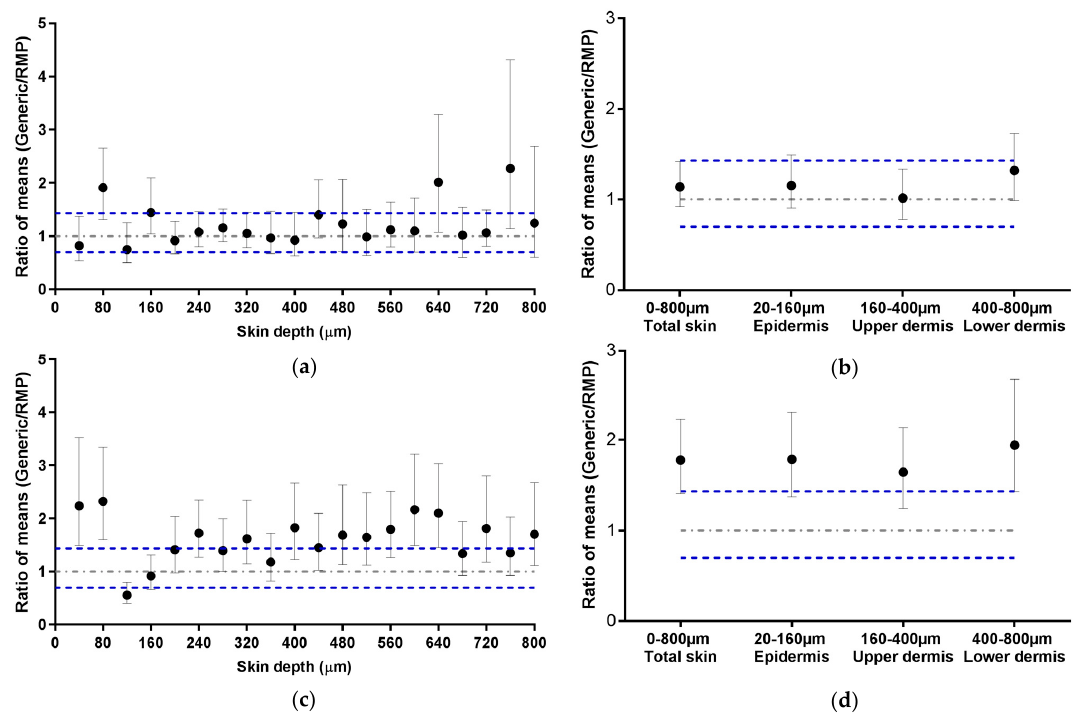
Figure 5. Ratio of mean ECZ depositions from the ECZ 1% Generic cream 1 and the RMP ( ): ( a ) in porcine skin lamellae (2 × 20 µm + 19 × 40 µm to 800 µm (full-depth) and ( b ) as a function of position in the anatomical regions of the skin (epidermis, upper and lower dermis) and in total skin, ( c ) in human skin lamellae (2 × 20 µm + 19 × 40 µm), from 2 donors, to 800 µm (full-depth), and ( d ) as a function of position in the anatomical regions of the skin (epidermis, upper and lower dermis) and in total skin. (Ratio ± CI 90% ; n = 12 for ( a , b ) and n = 24 for ( c , d )). Intervals of acceptance criteria were chosen according to the EMA guidelines; ( the mean ECZ deposition from the RMP; ( ) interval of 80.00–125.00% and ( ) interval of 69.84– 143.19%. P -values were calculated using a Student’s t test; statistically significant differences are denoted by asterisks (* p < 0.05; ** p < 0.005; *** p < 0.0005; **** p <